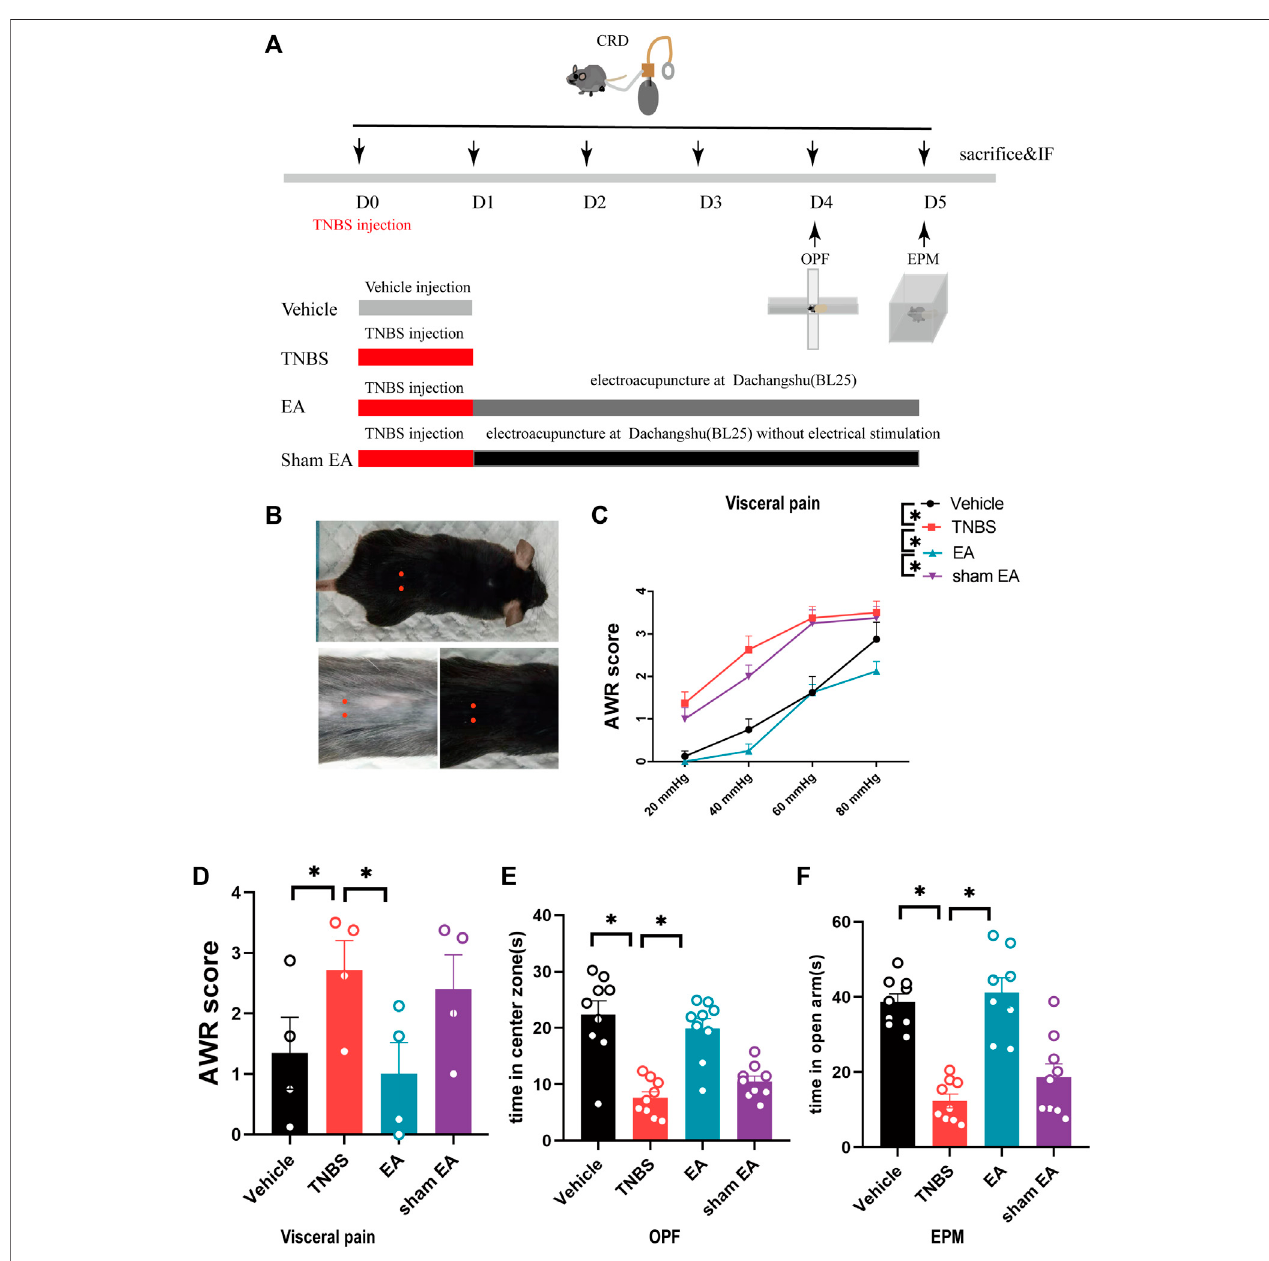
FIGURE1 | EA relieved the visceral hyperalgesia and anxiety-like behaviorsof IBD mice. (A) Experimental fl owchart. (B) Schematic diagram ofDachangshu points (BL25) on the skin surface. (C,D) Visceral hyperalgesia was evaluated by CRD. (E) Anxiety-related behaviors were recorded as time in center zone in the OPF. (F) Anxiety-relatedbehaviorswererecordedastimeinopenarmsintheEPM.Thedataareexpressedasmean±SEM( n =9mice).*represents p < 0.05betweenmarked groups.